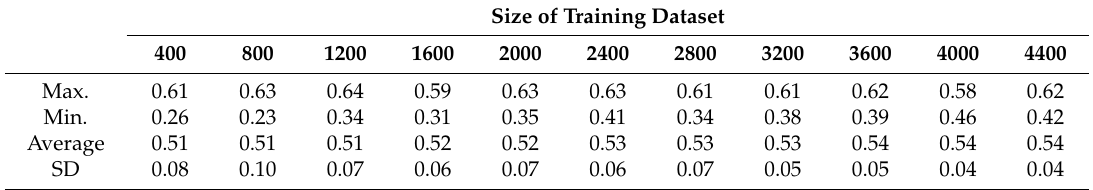
Figure 4. Model accuracy for spectral-yield displacement 𝑆 𝑑𝑦 with 11 building characteristics. Table 5. Model accuracy with testing 11 building characteristics for spectral-yield displacement 𝑆 𝑑𝑦 .